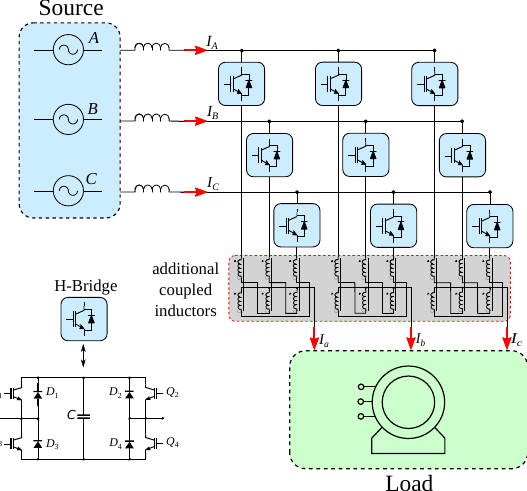
Figure 15. M3C topology with coupled inductors added to the